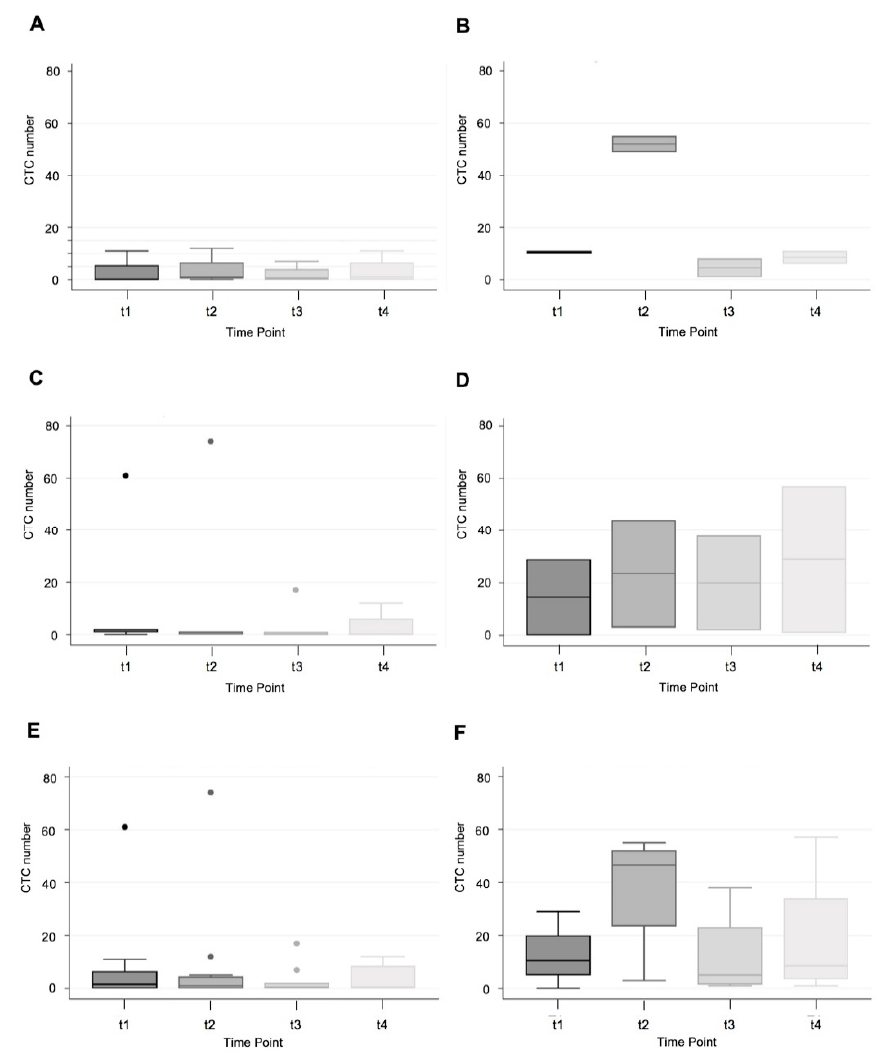
Figure 1. CTC number for stage II (Panels A and B ), III ( C and D ) and I-III (Panels E and F ) MSS (left) vs. MSI-H (right) colorectal cancer at different sample time points: t1 (pre-operative), t2 (intra-operative), t3 (immediate post-operative), t4 (14–16 h post-operative).